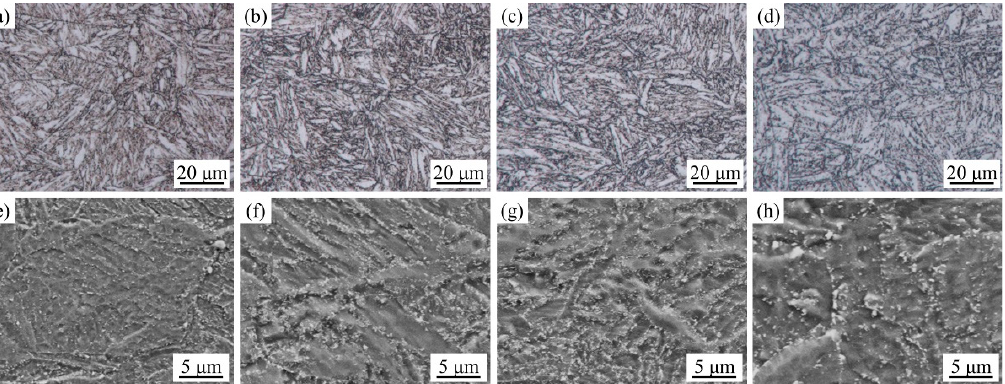
Figure 6. Microstructure morphology of 0.004Zr alloy treated by Process B, C, D, and E. ( a – d ) OM, ( e – h ) SEM, ( a ) and ( e ) 0.004ZrB, ( b ) and ( f ) 0.004ZrC, ( c ) and ( g ) 0.004ZrD, ( d ) and ( h ) 0.004ZrE.